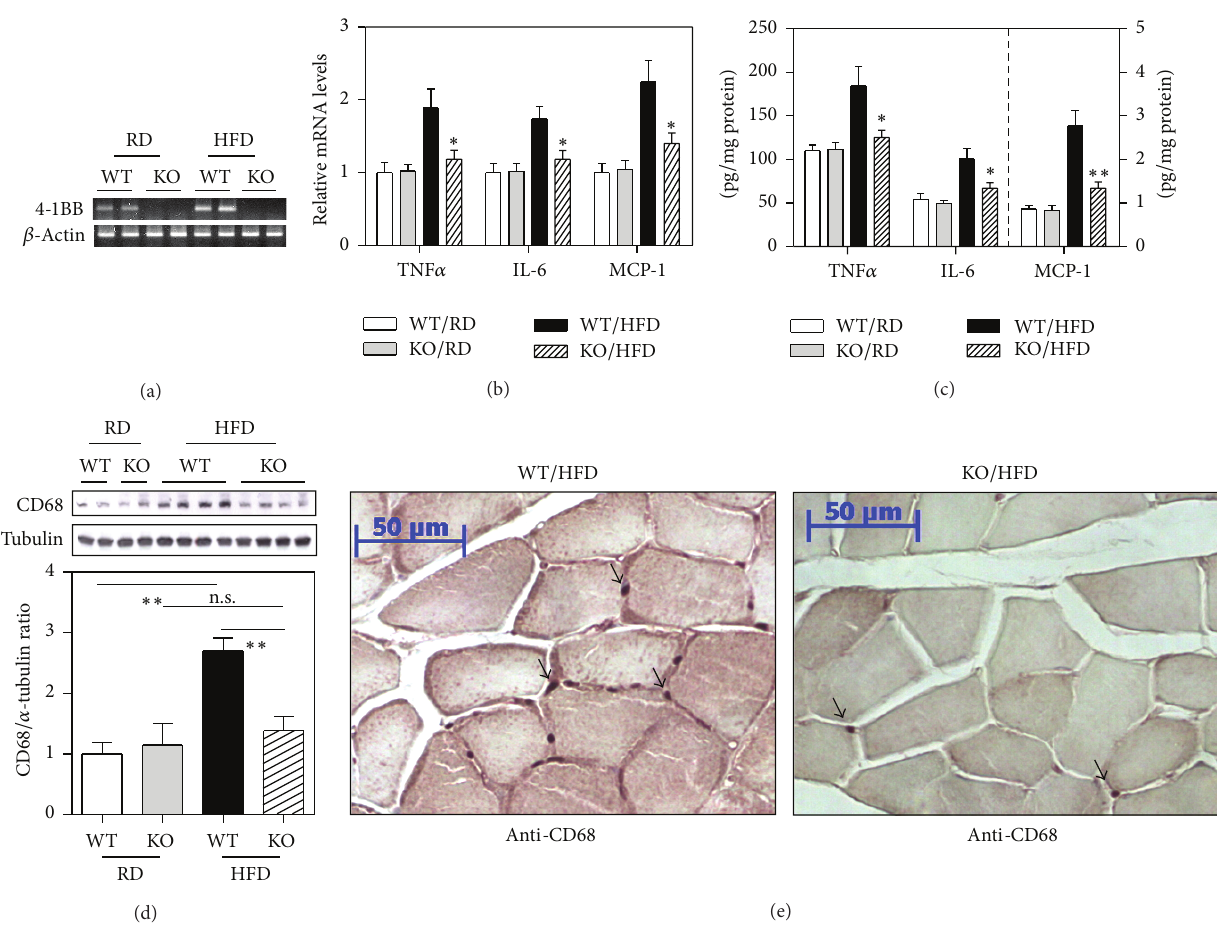
Figure 4: Deficiency of 4-1BB reduces inflammatory responses in skeletal muscle of HFD-fed mice. C57BL/6 wild-type (WT) and 4- 1BB-deficient mice were fed a RD or HFD for 9 weeks. (a) Representative bands of 4-1BB mRNA in skeletal muscle were determined by semiquantitative RT-PCR. ((b) and (c)) TNF 𝛼 , IL-6, and MCP-1 mRNAs and proteins were measured by qRT-PCR and ELISA, respectively. (d) Expression of CD68 and 𝛼 -tubulin was determined by Western blotting using the indicated antibodies. (e) Immunohistochemical staining for macrophage-specific CD68 in paraffin-embedded sections of the quadriceps muscle. Arrows indicate CD68-stained cells. Magnification 200; Scale bars 50 𝜇 m. Data are means ± SEM for 𝑛 = 6 . ∗ 𝑃 < 0.05 and ∗∗ 𝑃 < 0.01 compared with WT mice. n.s., not